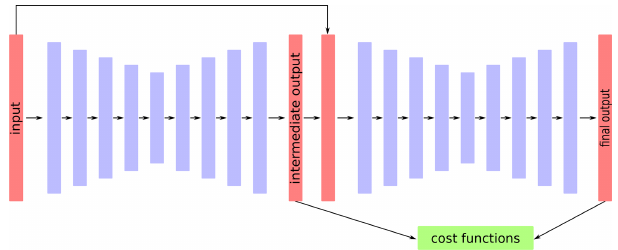
Figure 2. DINCAE with a refinement step composed essentially by two sequential autoencoders coupled such that the second autoen- coder uses the output of the first and the input